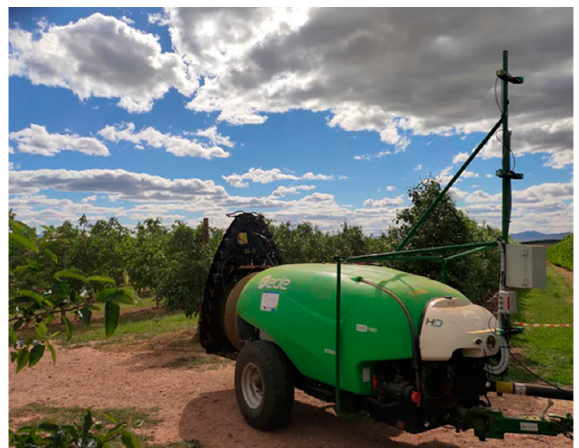
Figure 15. Prototype of the variable-rate sprayer developed in the European OPTIMA